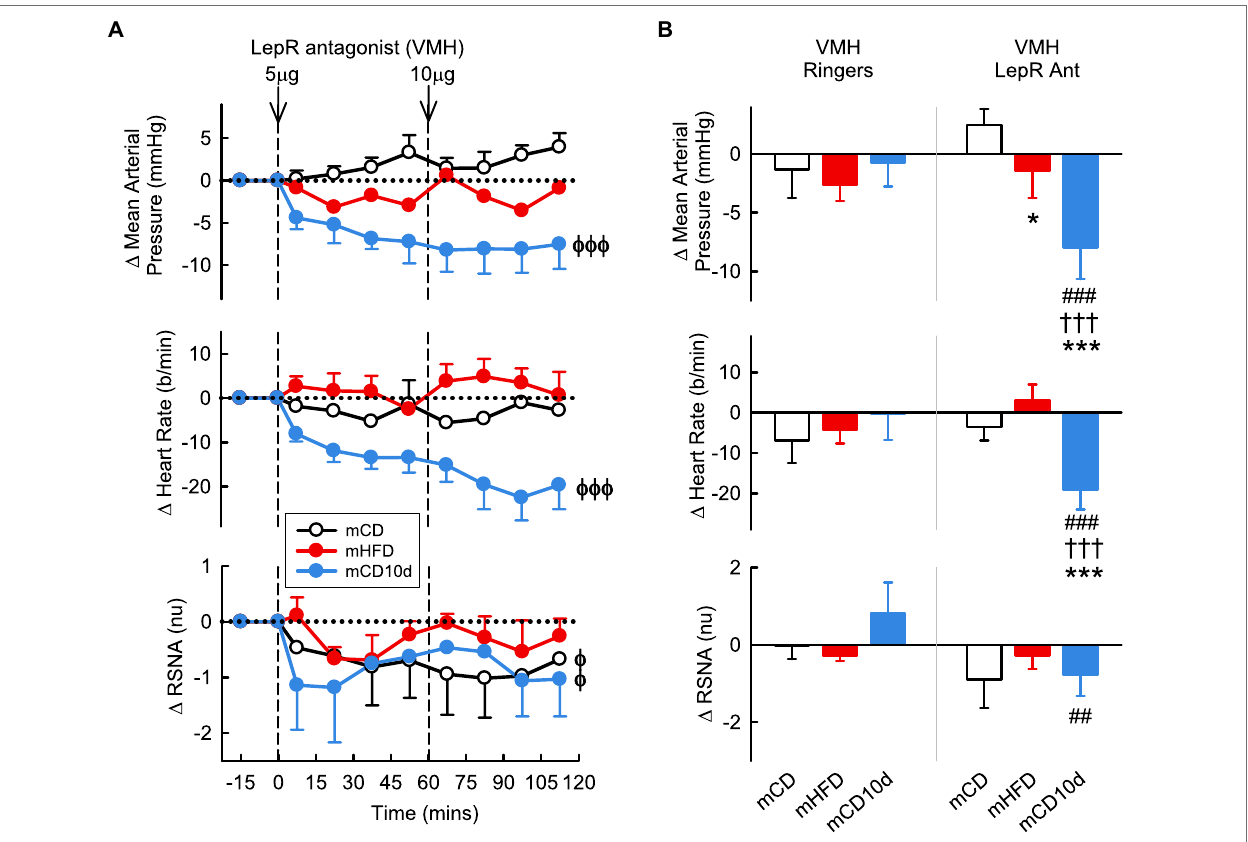
FIGURE 5 | Effects of LepR antagonist injected into the VMH. (A) Average changes in MAP, heart rate, and RSNA (normalized units) from control in each group after VMH injection of LepR antagonist (5, 10 μ g, shown at dashed lines) in mCD (white, n = 6), mHFD (red, n = 6), and mCD10d (blue, n = 6) rabbits. Data are mean difference ± SED. ϕ p < 0.05, ϕϕϕ p < 0.001 for average effect of LepR antagonist. (B) Changes from control after administration of vehicle Ringer’s and LepR antagonist, averaged over the second dose, given into the VMH in mCD, mHFD, and mCD10d rabbits. Data are mean difference ± SED from the control period of each treatment group. * p < 0.05 and *** p < 0.001 for comparison to mCD; ††† p < 0.001 for mHFD vs. mCD10d; ## p < 0.01 and ### p < 0.001 for effect of LepR antagonist vs.